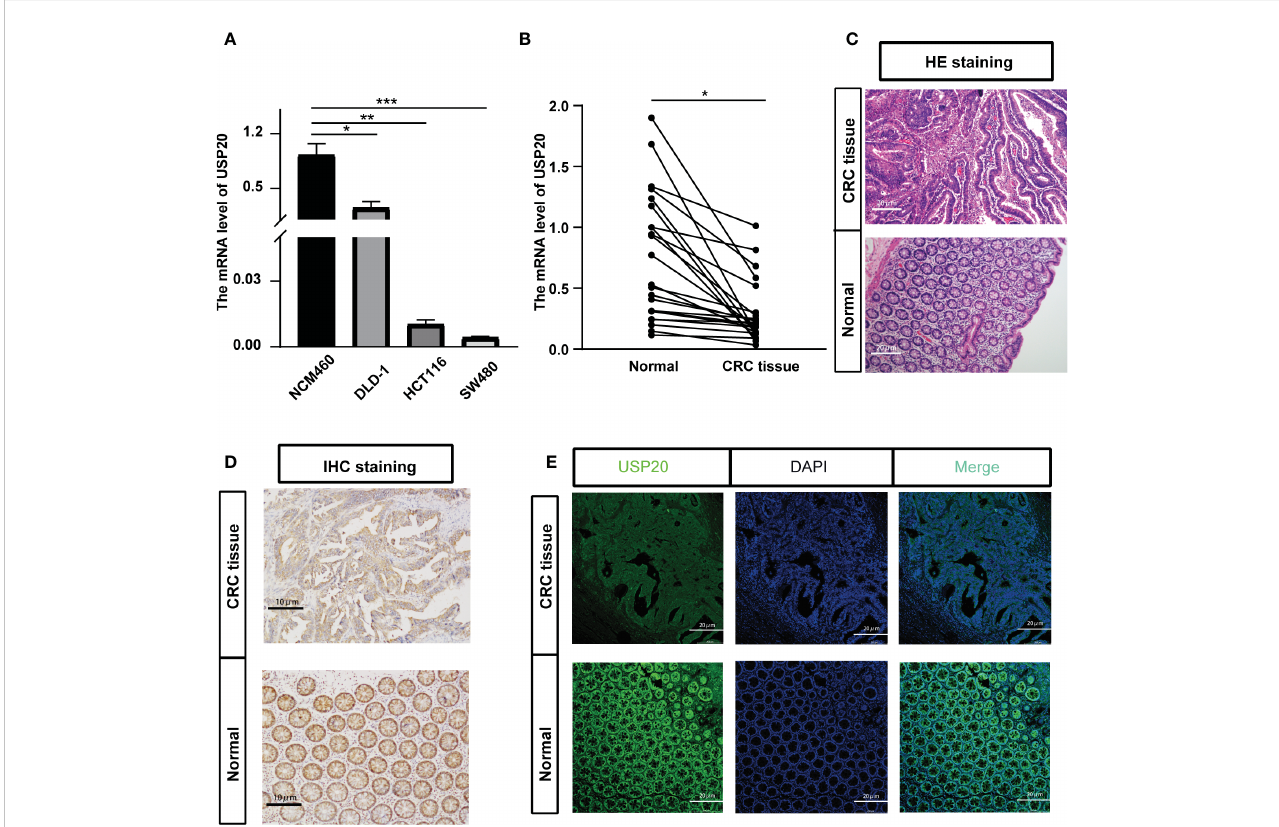
FIGURE 3 Veri fi cation the USP20 expression in CRC samples; (A) Quantitative real-time PCR (qRT-PCR) was performed to detect the mRNA level of USP20 in CRC cell lines and normal human colonic epithelial (NCM460) cells; (B) Quantitative real-time PCR (qRT-PCR) was performed to detect the mRNA level of USP20 in 23 CRC tissues and correspond adjacent normal tissues; (C) HE staining clari fi ed the CRC tissue and normal tissue in the pathological tissue (100x); (D) Immunohistochemical (IHC) staining was used to detect the difference in expression of USP20 between CRC tissues and adjacent normal tissues(200x); (E) immuno fl uorescence assays was used to determine the subcellular localization of the USP20 protein in CRC tissues(200x); (*P < 0.05; **P < 0.01; ***P < 0.001; ****P < 0.0001; NS, not signi fi cant).